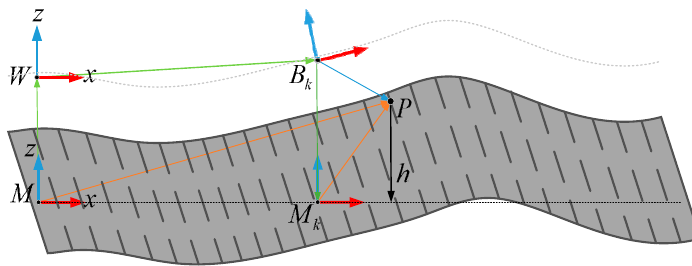
Figure 4. Automobile sub-coordinate system.